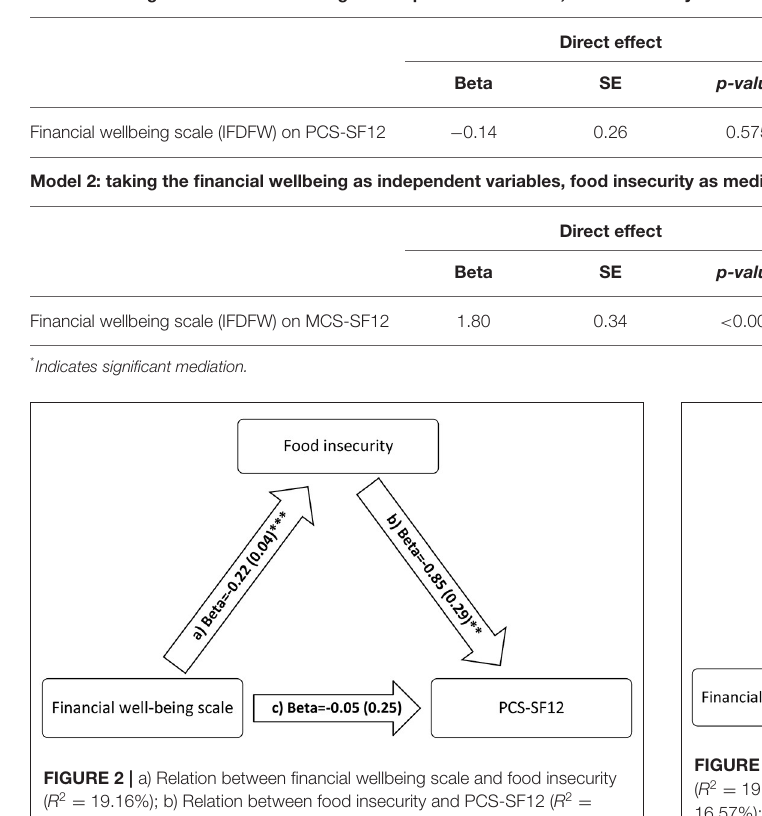
TABLE 5 | Mediation analyses.